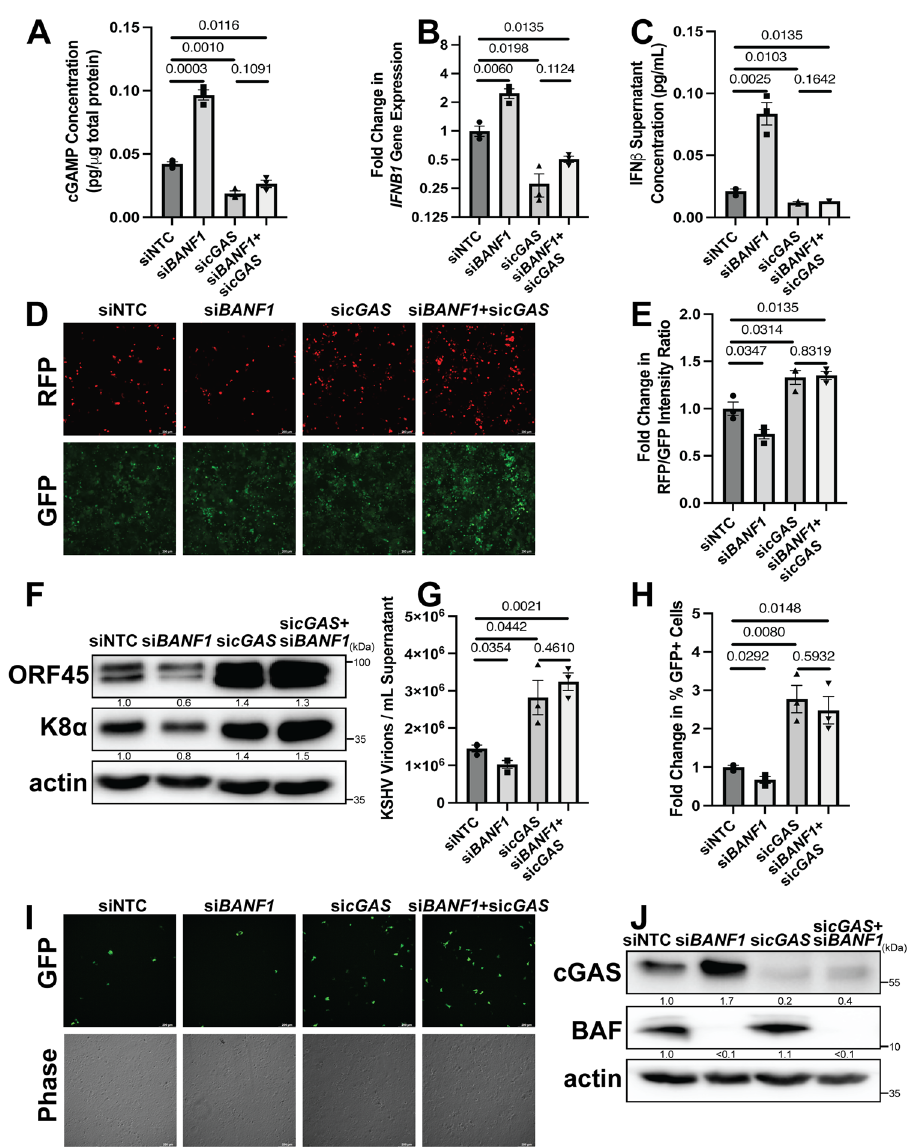
Fig. 4 | BAF promotes KSHV reactivation through a cGAS-dependent mechanism. iSLK.219 cells were transfected with NTC, BANF1 , cGAS , or BANF1